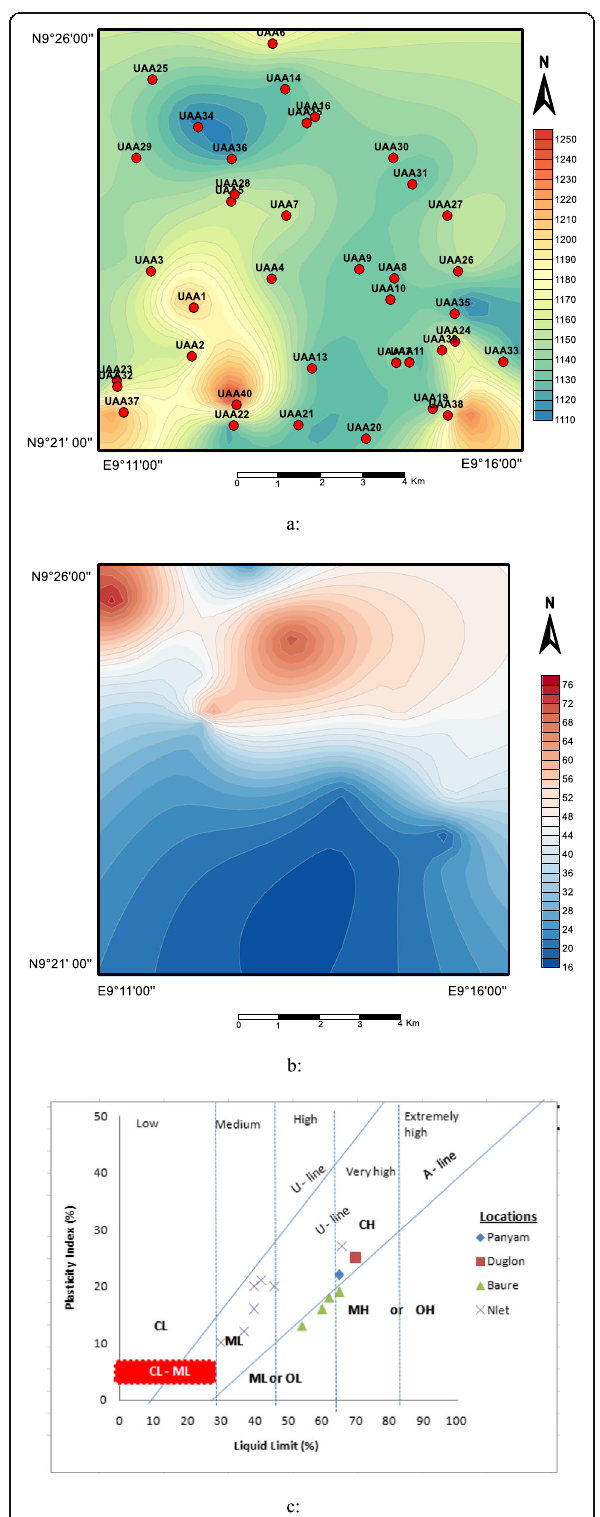
Fig. 4 a Figure showing sampling distribution in the area. b Figure showing the distribution of clay fraction in the area. c Plasticity chart of cohesive soils of the